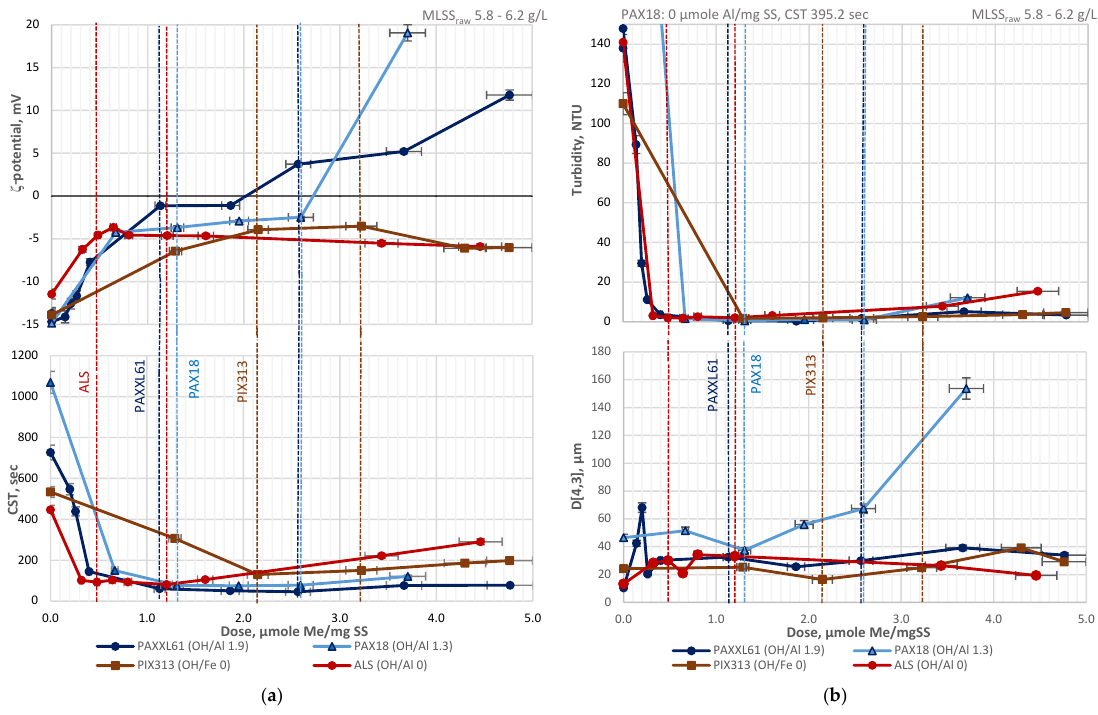
Figure 5. Influence of the coagulant dose on the monitored parameters at fixed pH during the jar tests: ( a ) zeta potential, capillary suction time (CST); ( b ) turbidity, the volume moment